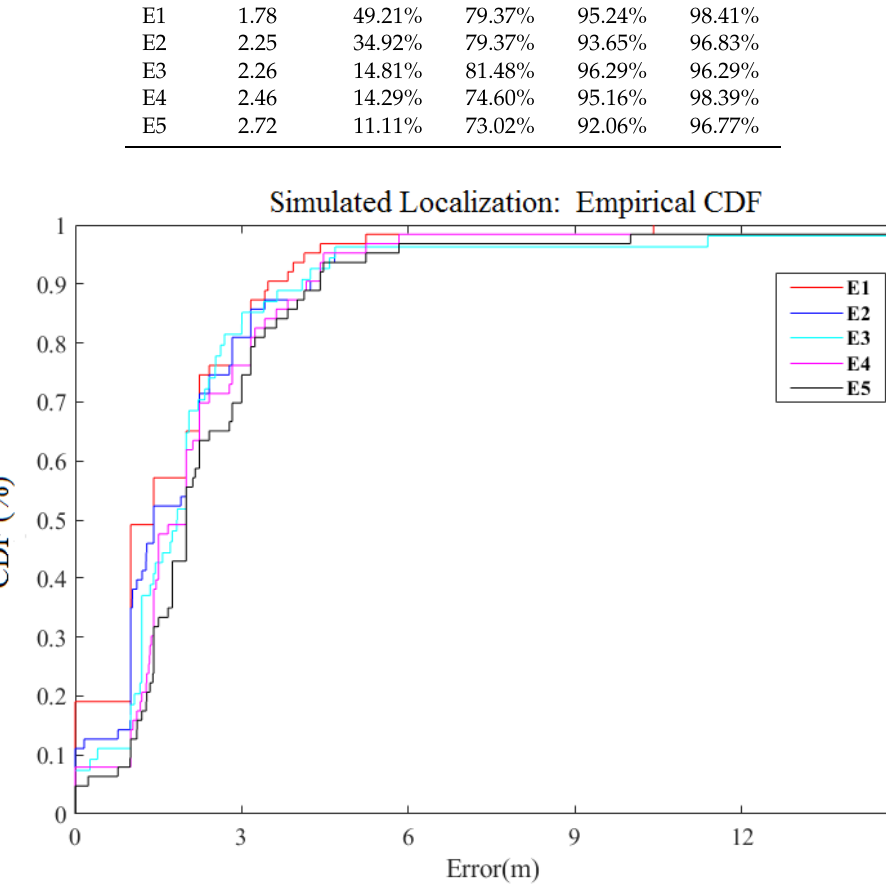
Figure 10. CDF of simulated localization error for different obstacle environments.